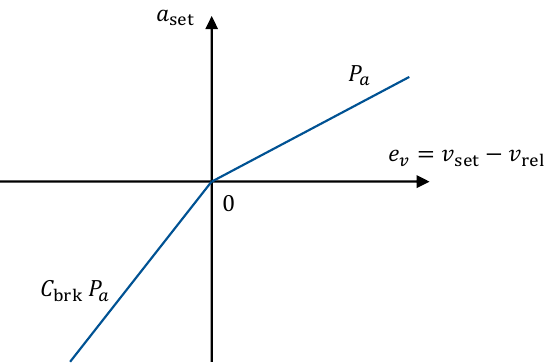
Figure 14. Different P-coefficient in the positive and negative directions.